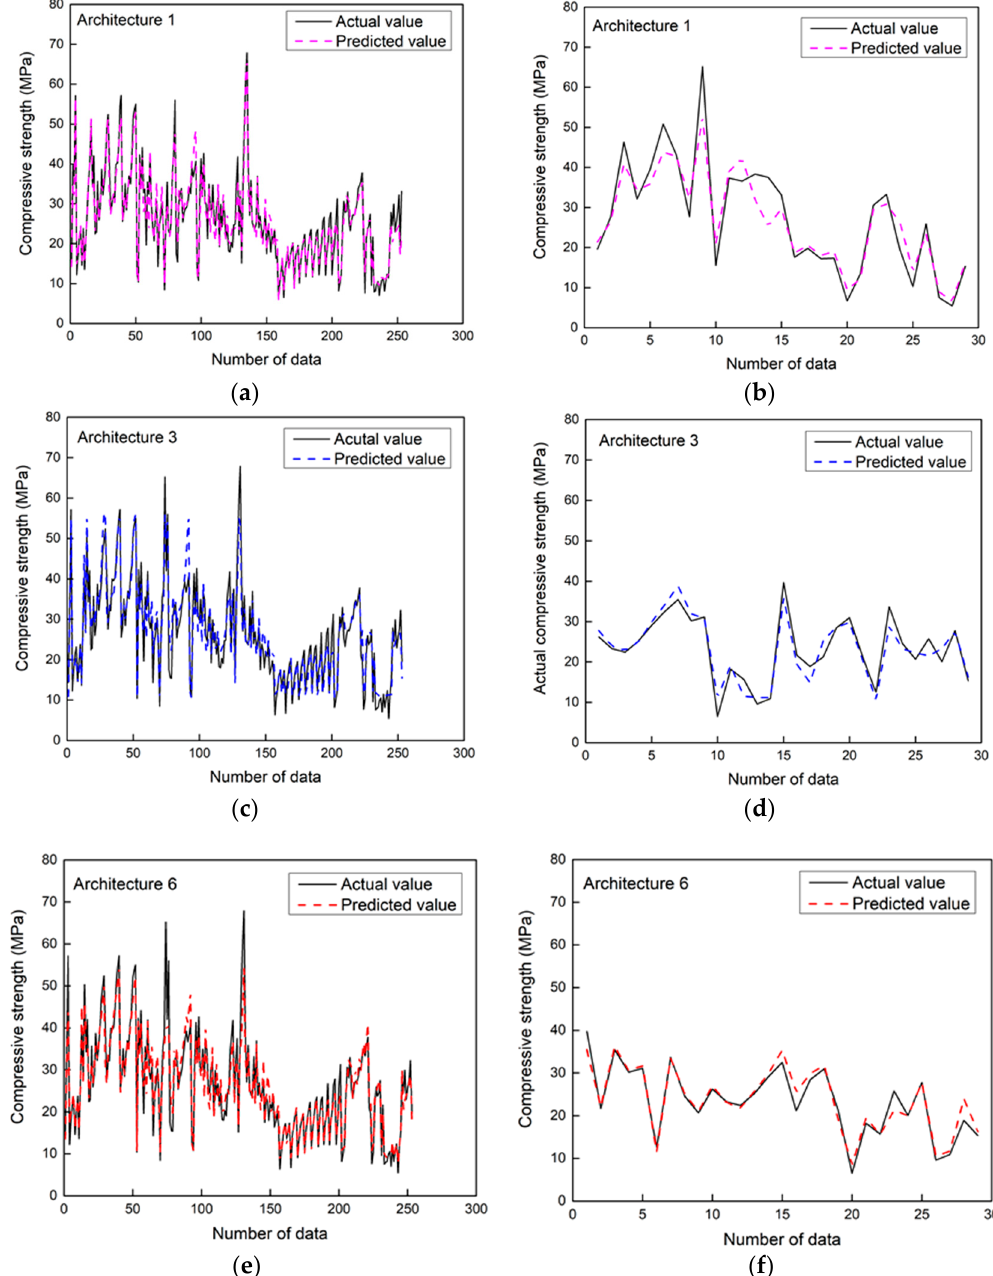
Figure 6. Relationship between compressive strength values obtained from experiments (actual value) and machine learning approaches (predicted value): ( a ) training ANN; ( b ) validation ANN; ( c ) training DNN; ( d ) validation DNN; ( e ) training ResNet; ( f ) validation ResNet.